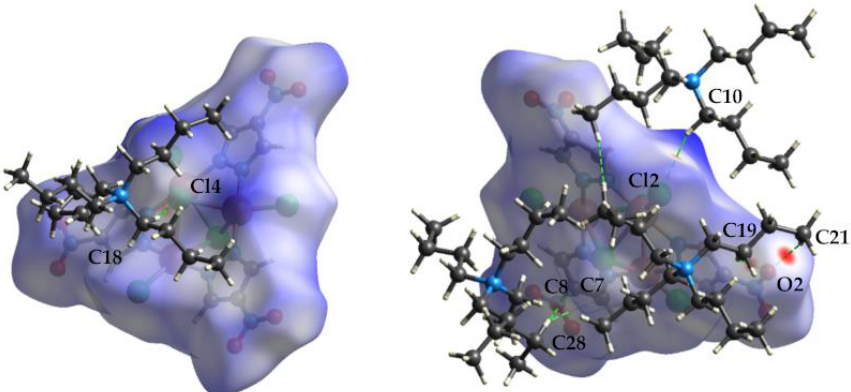
Figure 7. Hirshfeld surface of the front ( left ) and back ( right ) of the [Cu 3 (μ 3 -Cl) 2 (μ -4-NO 2 -pz) 3 Cl 3 ] 2- unit of 1c showing the intermolecular interactions with the tetrabutylammonium cations. From the d norm Hirshfeld surfaces, 2D fingerprint plots were assembled as shown in Figure 8. All three polymorphs show the most interactions (dark blue = small number of interactions, while green = moderate number of interactions) around d i ≈ 2 Å, d e ≈ 1.4 Å. The main difference between the shape of each plot is the number of interactions at high d i /d e values. 1a is the densest polymorph, and thus its surface has fewer long-range inter- actions (those above d i ≈ d e ≈ 2.6 Å). The other main difference is the number of spikes of each fingerprint plot. 1a has two main spikes. The first is located roughly at d i ≈ 1.4 Å, d e ≈ 1.1 Å and continues diagonally upwards. This depicts the O…H interactions. The second spike is located roughly at d i ≈ 1.6 Å, d e ≈ 1.0 Å and continues diagonally upwards. This spike i s attributed to the Cl…H interactions. 1b has the highest number of spikes (four) of the polymorphs: (1) d i ≈ 1.1 Å, d e ≈ 1.4 Å; (2) d i ≈ d e ≈ 1.2 Å; (3) d i ≈ 1.3 Å, d e ≈ 1.0 Å; and (4) d i ≈ 1.7 Å, d e ≈ 1.1 Å. The O…H interactions account for the first and third spikes. The second spike is attributed to the H…H interactions , and the fourth spike is attributed to the Cl…H interactions. The Cl…H interactions of 1b are not as strong as those of 1a ; how- ever, the O…H interactions of 1b are stronger than those of 1a . The plot of 1c shows three spikes: (1) d i ≈ d e ≈ 1.1 Å; (2) d i ≈ 1.4 Å, d e ≈ 1.0 Å ; and (3) d i ≈ 1.7 Å, d e ≈ 1.1 Å. These are attributed to the H…H, O…H, and Cl…H interactions, respectively. Here, the H…H in- teractions are slightly stronger than in 1b , while the strength of the O…H interactions is similar to 1a , and the strength of the Cl…H interactions is similar to 1b . The breakdown of the 2D fingerprint plots by type of atomistic contribution is shown in Figures S1 – S3 of the supplementary information.